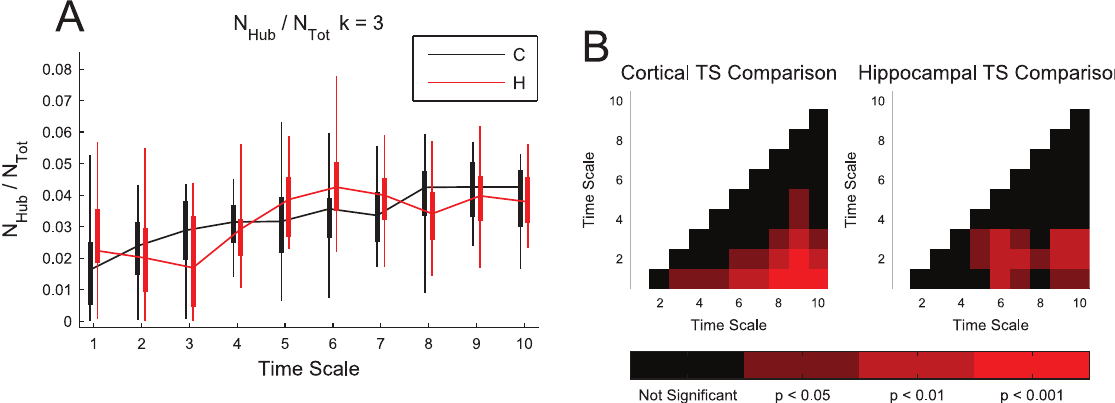
Fig. 4. A small and consistent percentage of neurons were found to be hubs. ( A ) Most data sets exhibited a small, but significant number of hubs across all time scales. Note that the likelihood for a randomly connected neuron to be found to be a hub was set at 10 2 4 (see Materials and Methods ), so these results indicate a roughly two order of magnitude increase in the number of hubs over a random network. Box plots: minimum, 25 th percentile, median, 75 th percentile, maximum data set (recording). No significant differences were found between hippocampal and cortical networks. ( B ) Multiple comparison corrected Mann-Whitney Test p-values between different time scales for the same tissue type. The number of hubs generally increased with time